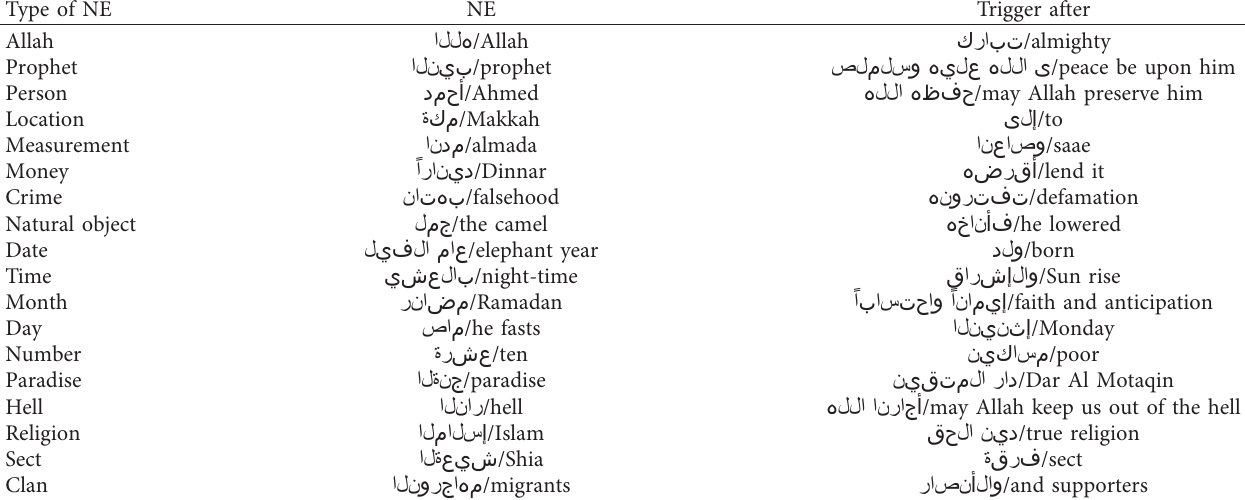
Table 5: Examples of